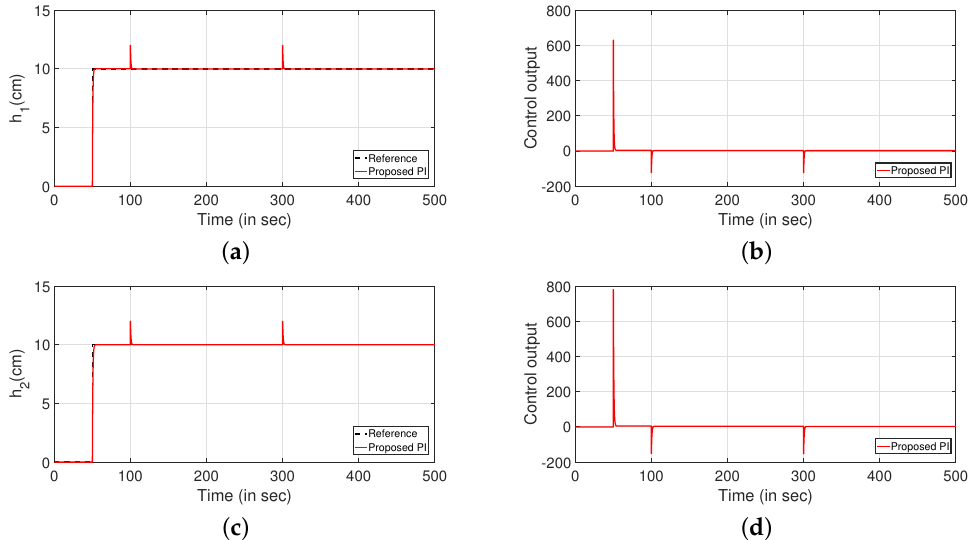
Figure 22. Regulatory response. ( a ) Level Variation in tank 1. ( b ) Control output. ( c ) Level Variation in tank 2. ( d ) Control